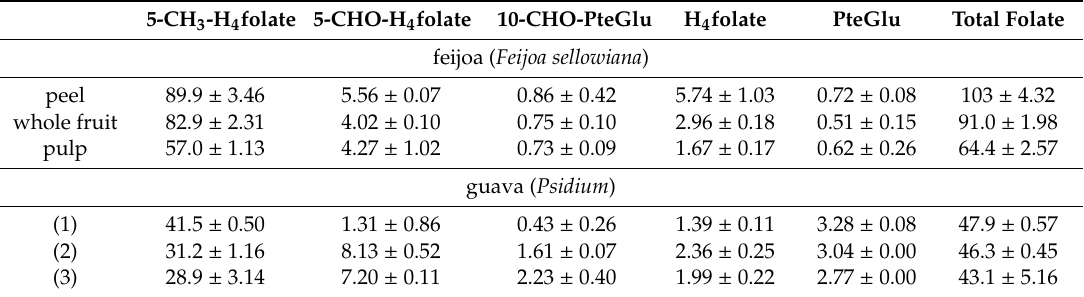
Table 2. Total folate content ( µ g / 100 g, calculated as PteGlu) in